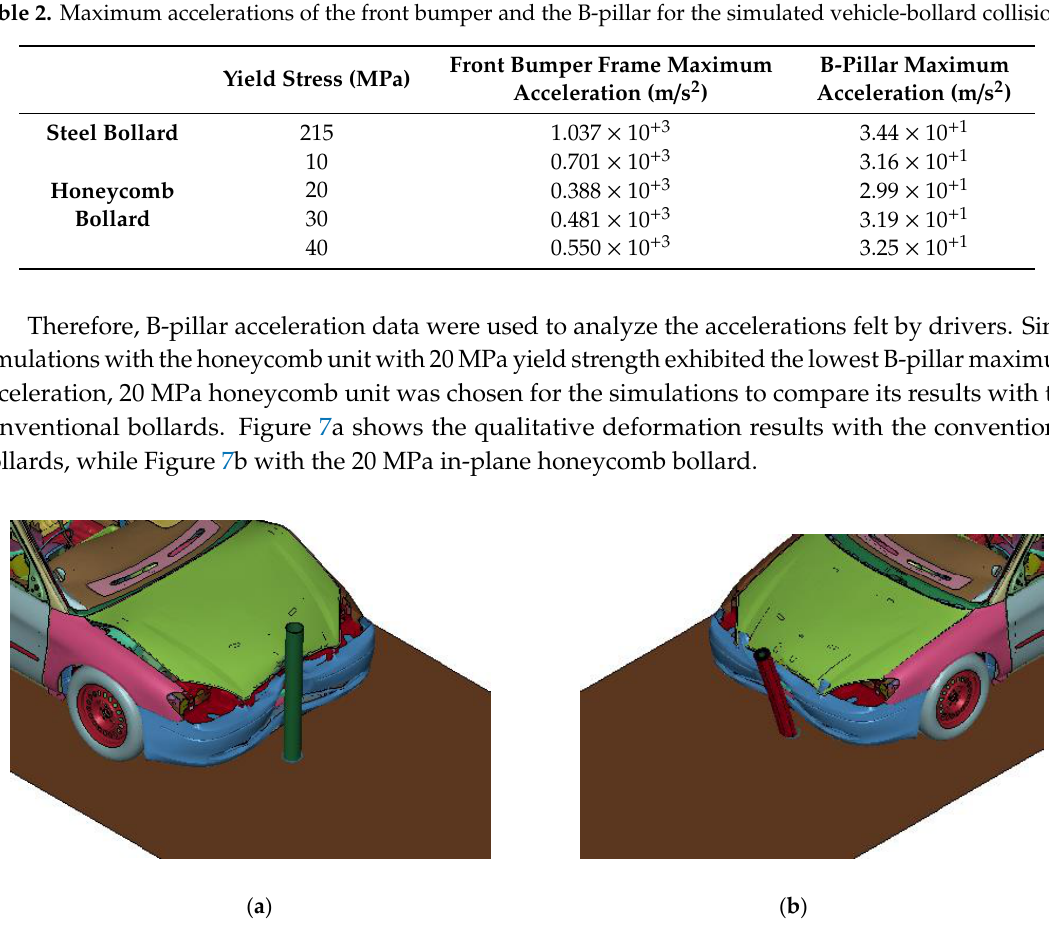
Figure 7. Maximum deformation of collision between vehicle and bollard; ( a ) steel bollard; ( b ) honeycomb 20 MPa bollard. Table 2. Maximum accelerations of the front bumper and the B-pillar for the simulated vehicle-bollard collisions.